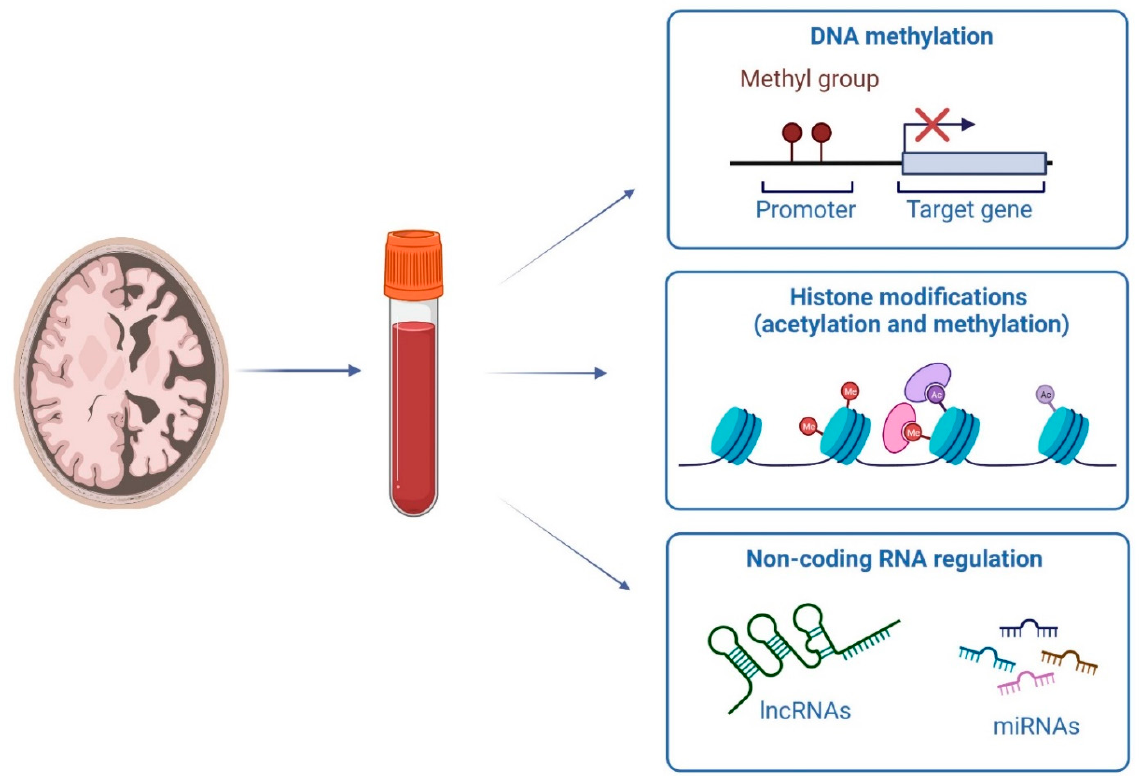
Figure 1. Epigenetic peripheral modifications for the early diagnosis of AD.